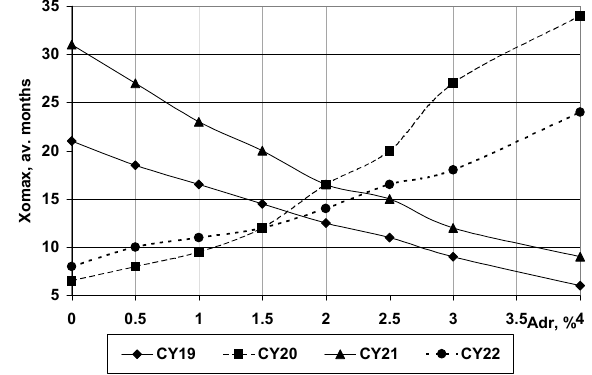
Fig.1. Fig. 1. The first and second approaches of the different influence Fig. 3. Fig. 3. Dependences X o max (A dr ) for Climax NM in the frame of of drift effects on the observed time lag in odd and even cycles: the third drift “CD” is convection-diffusion modulation with a total change of 20% (as about in Climax NM data), “CD+DR2” and “CD+DR1” are “observed”, including convection-diffusion and drift modula- tions; “DR2-4%” and “DR1-4%” are supposed drift effects with amplitude A dr = 4% (right ordinate).